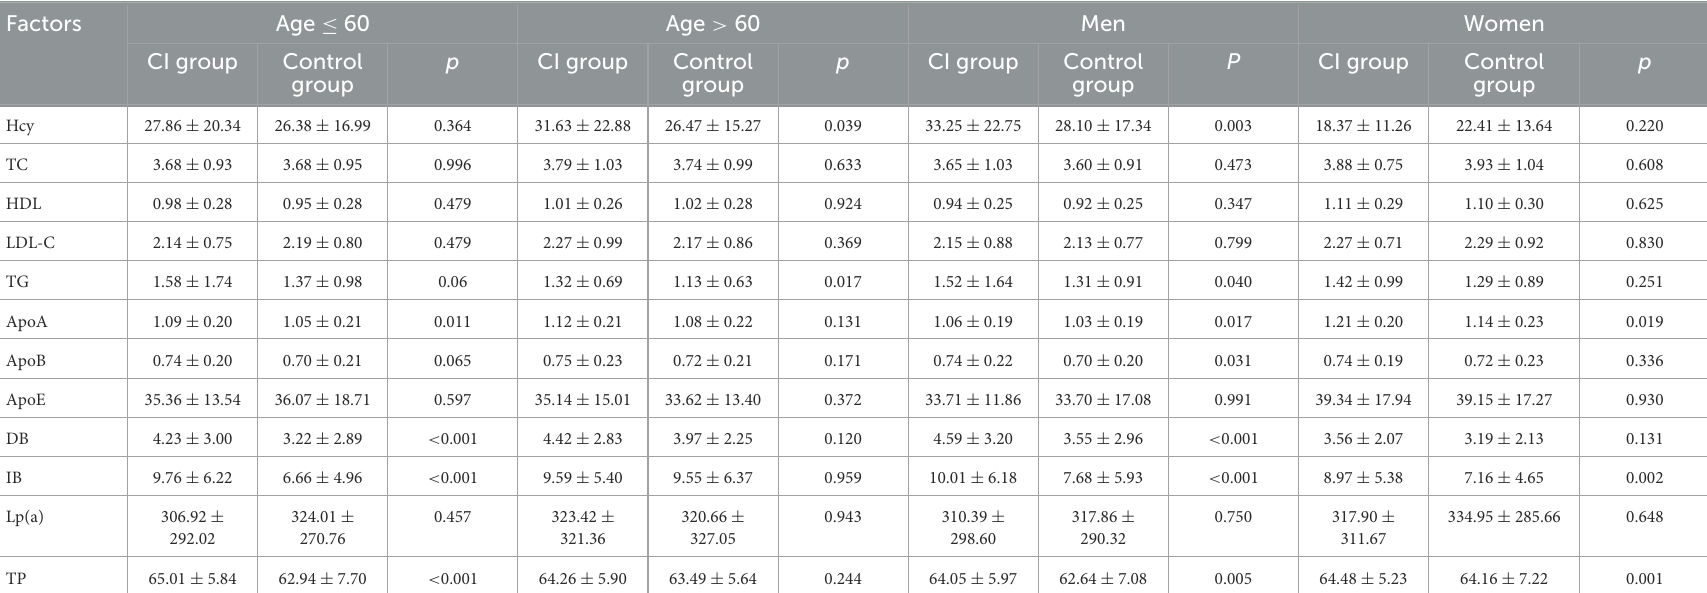
TABLE 2 Stratified analyses of lipid levels by age and sex.